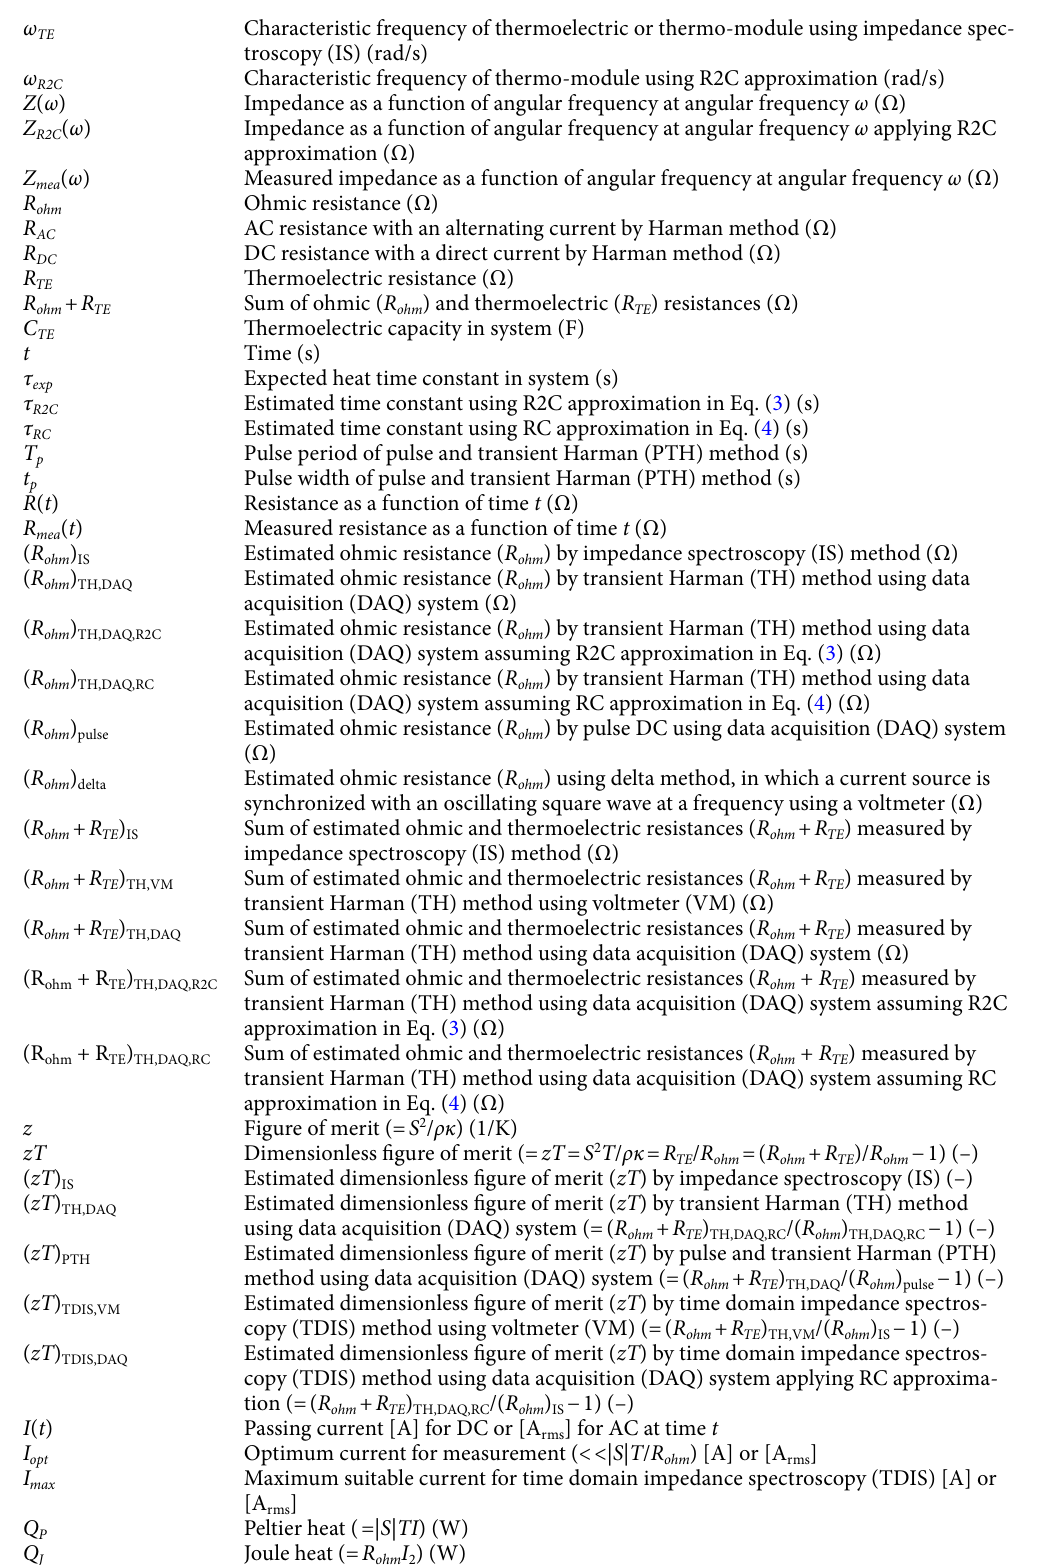
Figure of merit (= S 2 / ρκ )